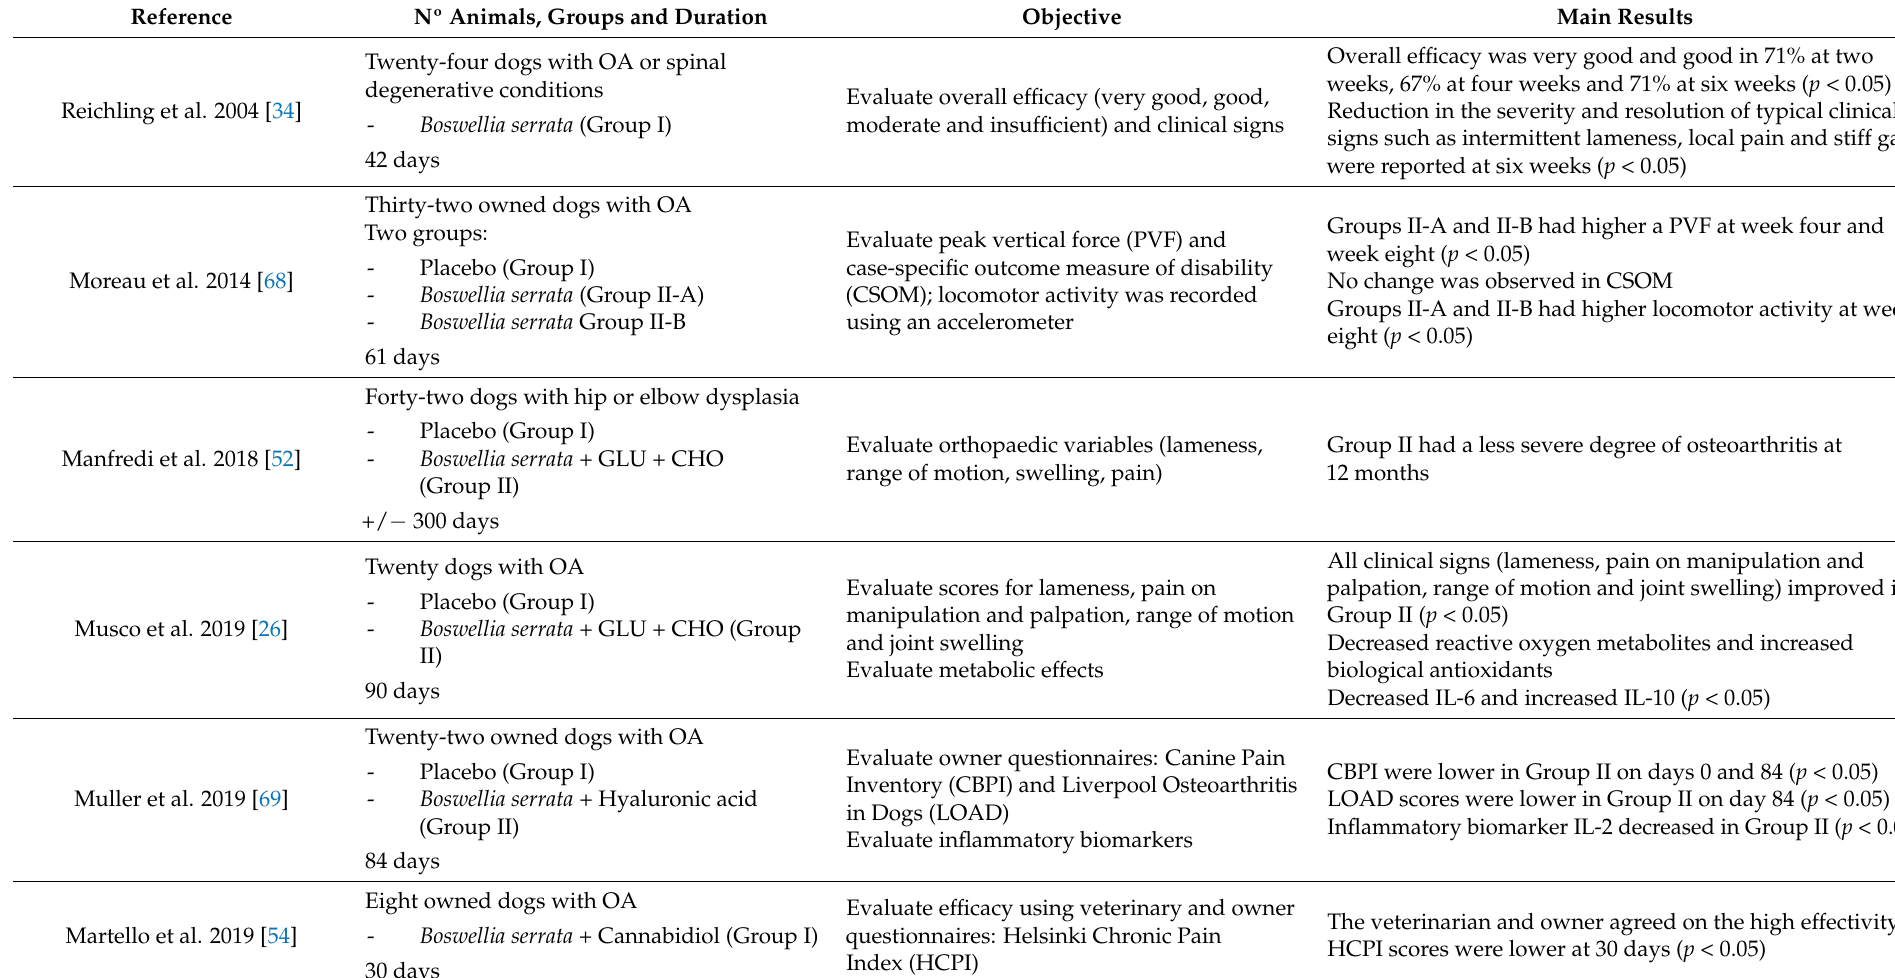
Table 6. Literature overview of the evidence regarding Boswellia serrata for the management of osteoarthritis (OA) and joint support in